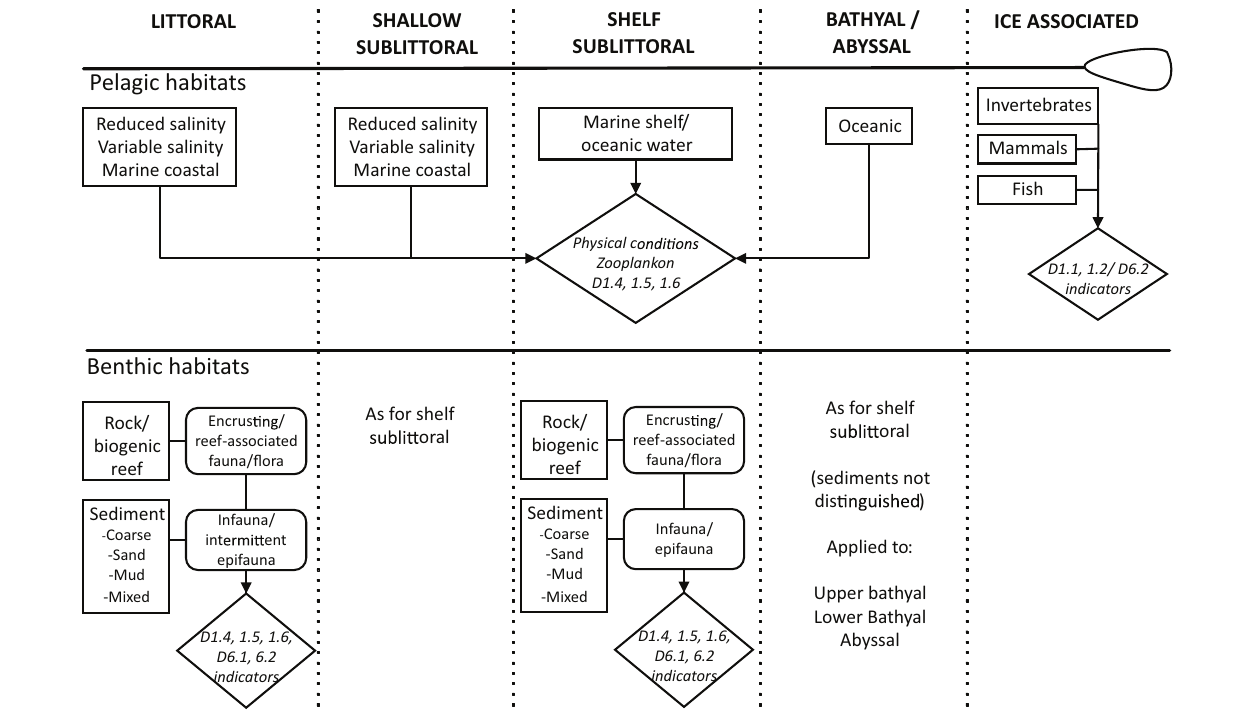
Frontiers in Marine Science |